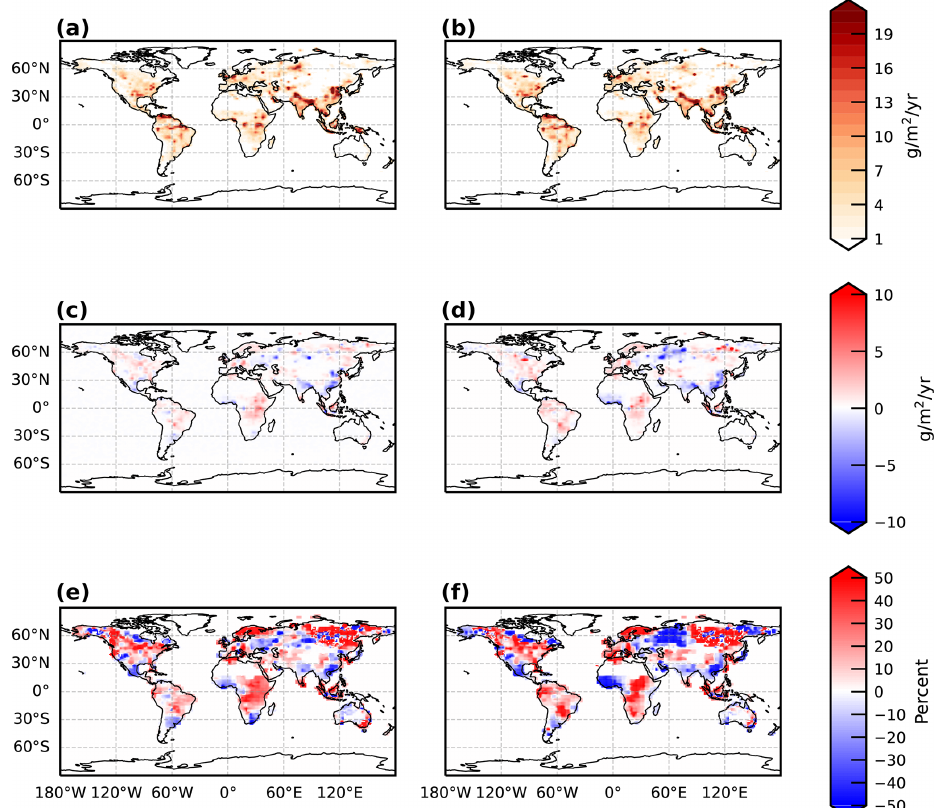
Figure 2. Global a posteriori emissions of methane (gm − 2 yr − 1 ) inferred from GOSAT methane:CO 2 column ratio data for (a) 2020 and (b) 2021 and how they differ from the baseline year of 2019, described in terms of ( c, d , respectively) absolute and ( e, f , respectively) percentage values.